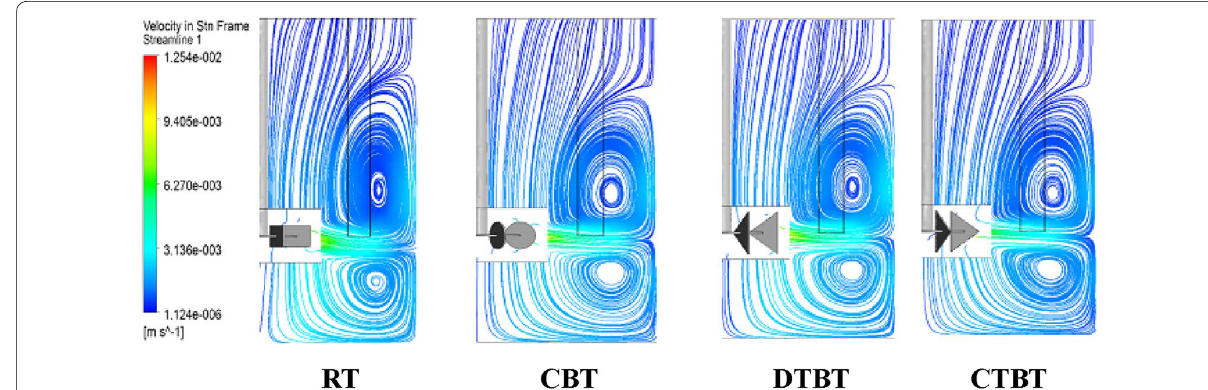
Figure 10 Stream lines for agitator’s types with L / H